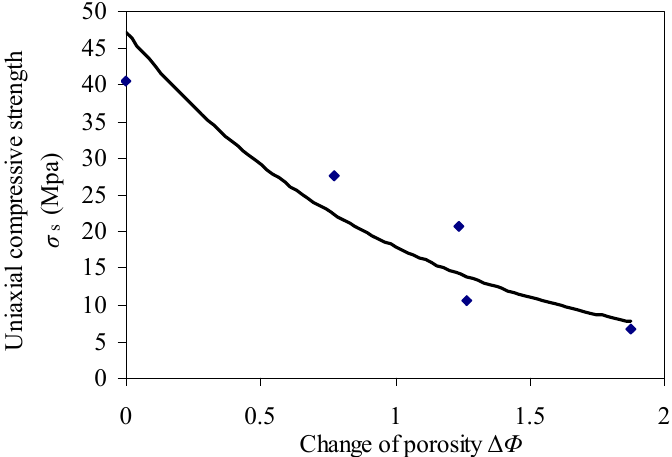
Figure 12. Change of porosity versus compressive strength.